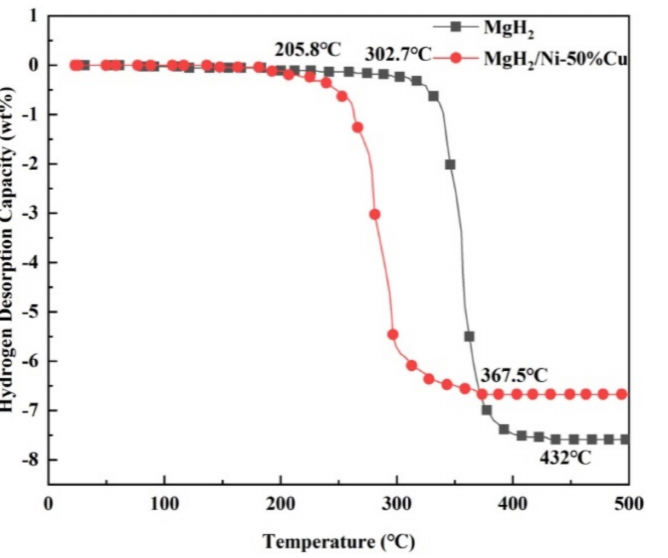
Figure 12. TPD curves of the as-milled MgH 2 and MgH 2 /Ni–50% Cu systems with a heating rate of 3 ◦ C/min [112]. (Reprinted with permission from Elsevier).